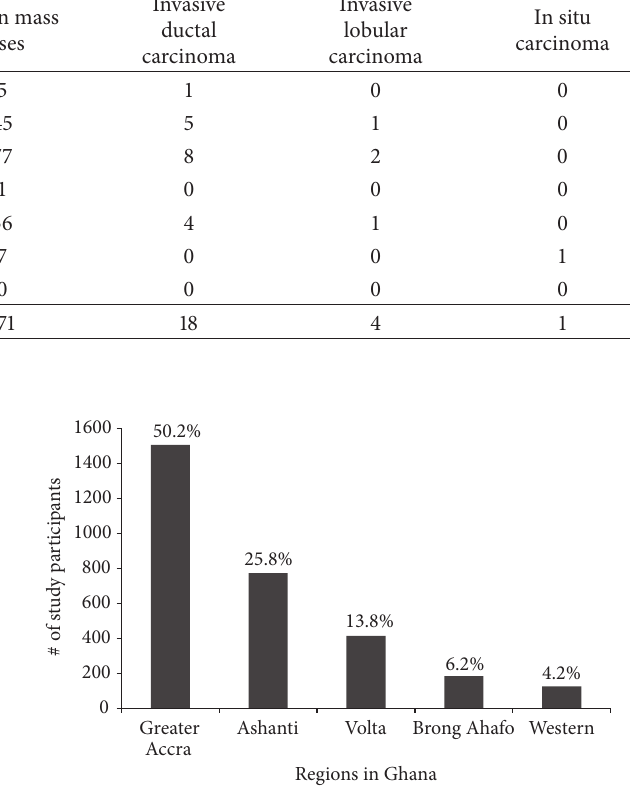
Figure 1: Population distribution of study participants by region. The 3000 female participants in the study were selected based on population density of the region, willingness of participants, and accessibility to treatment facilities for referrals. Percentages shown here were calculated as a fraction of participants in every region over total number of participants